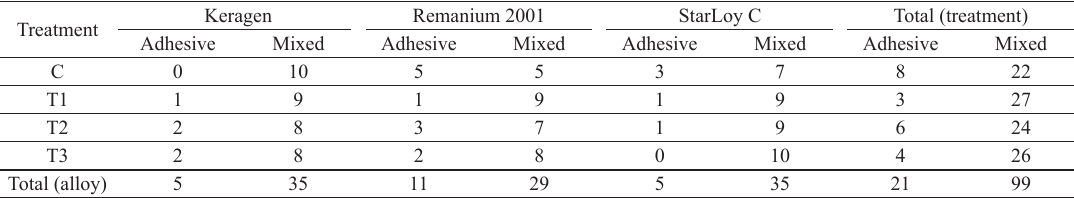
Table 4. Distribution of the type of failures found in all treatments performed on Co-Cr surfaces.